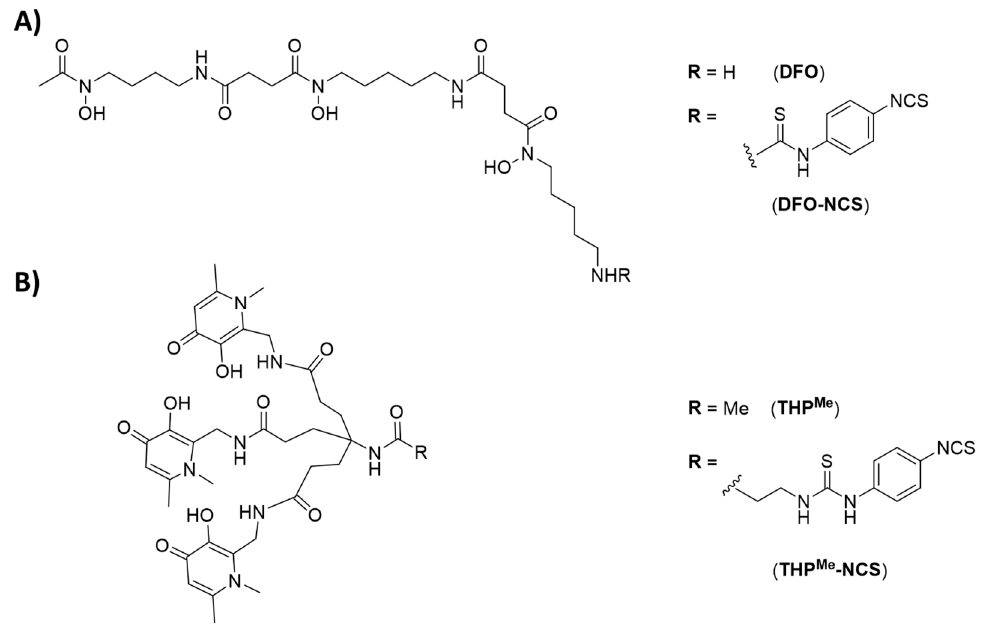
Figure 1. Chemical structures of the chelators used in this work. ( A ) Bifunctional chelator (DFO) and its bifunctional analogue DFO-NCS, ( B ) THP Me and THP Me -NCS.